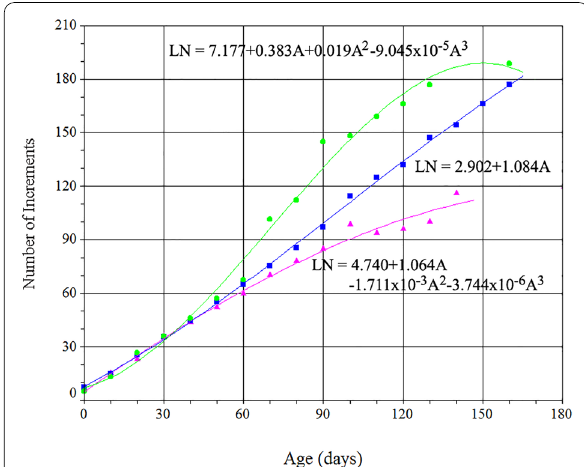
Fig. 2 Relationships between age (days) and number of increments, (circle – Sepioteuthis lessoniana , rectangle— Sepia pharaonis , triangle— Sepiella inermis )